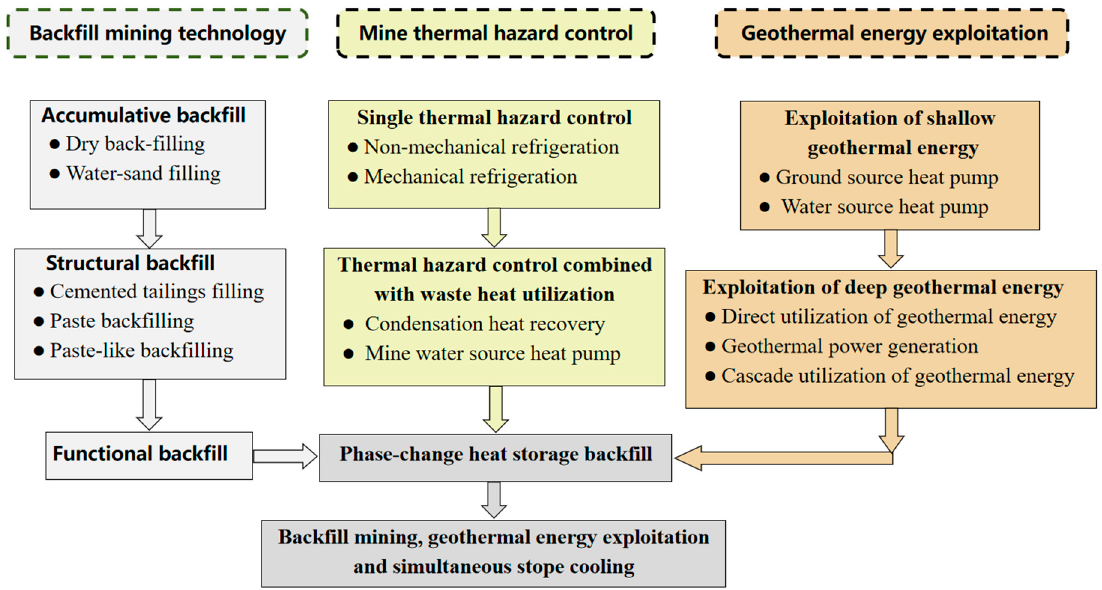
Figure 1. The concept for the phase-change heat storage backfill.